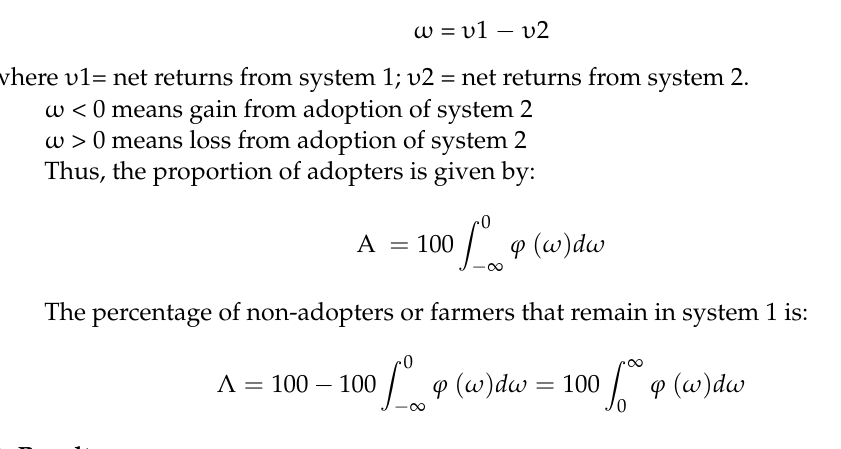
Figure 6. Pathways and future production systems. Source : [6,10].